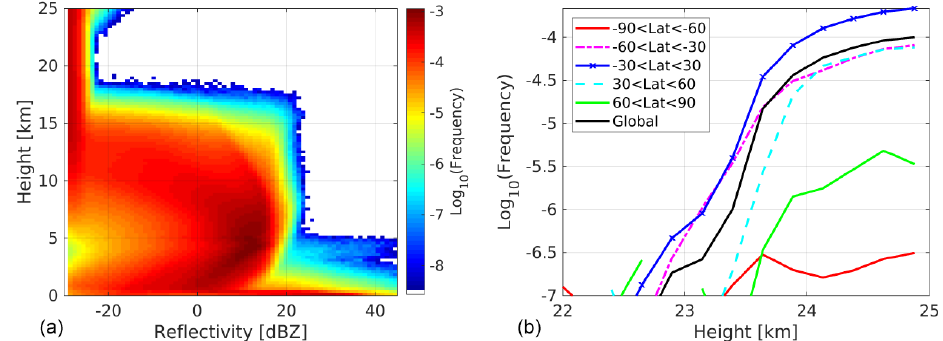
Figure 7. (a) CFAD for CloudSat profiles in convection for 2008 and 2009. The appearance of second-trip echoes is clearly visible above 23km. (b) Frequency of second-trip echoes for convective profiles as a function of height for different latitudinal bands as indicated in the legend.